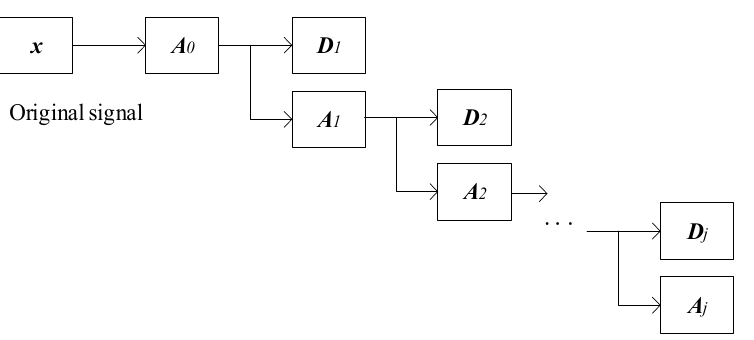
Figure 3. The multi-scale decomposition of multi-resolution singular value decomposition (MRSVD).